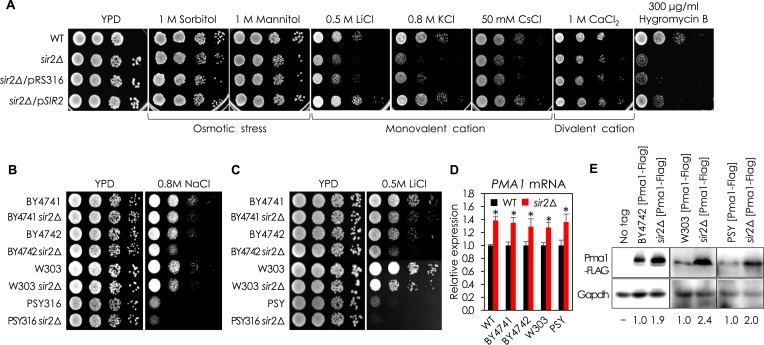
Sir2 is involved in regulation of monovalent cations in yeast.(A) sir2∆ mutant was sensitive to various monovalent cations and Hygromycin B, but not to divalent cation or osmotic stress, than WT. WT, sir2∆, sir2∆ cells transformed with an empty low-copy vector (pRS316) or pRS316 carrying the SIR2 gene were spotted onto each plate as indicated and incubated at 30°C for 2 days. (B, C) sir2∆ mutants of all strains tested were more sensitive to NaCl (B) and LiCl (C) than WT in solid medium. (D) PMA1 mRNA levels in sir2∆ mutants were higher than those in WT strains (*, vs WT in an indicated strain, p < 0.03). The values are the average of at least three independent experiments (±S.D.). (E) Pma1 protein levels in WT strains and their sir2∆ mutants were analyzed by Western blotting using an anti-Flag antibody. GAPDH protein was used as a loading control.